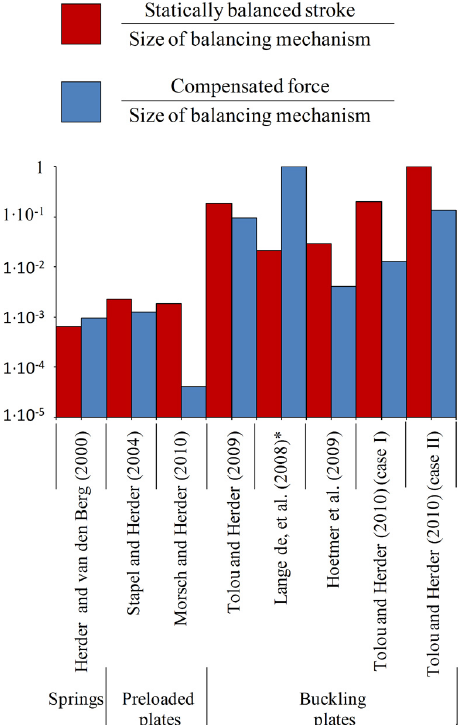
Figure 8. The ratios of statically balanced stroke and compensated force relative to the size of the balancing mechanism. Note that the ratios were normalized to the largest in the group and shown in log- arithmic scale. The balancing mechanism used springs, preloaded plates or buckling plates to balance the mechanism. * This design has an exceptionally high compensated force, but was never fabricated due to calculated high